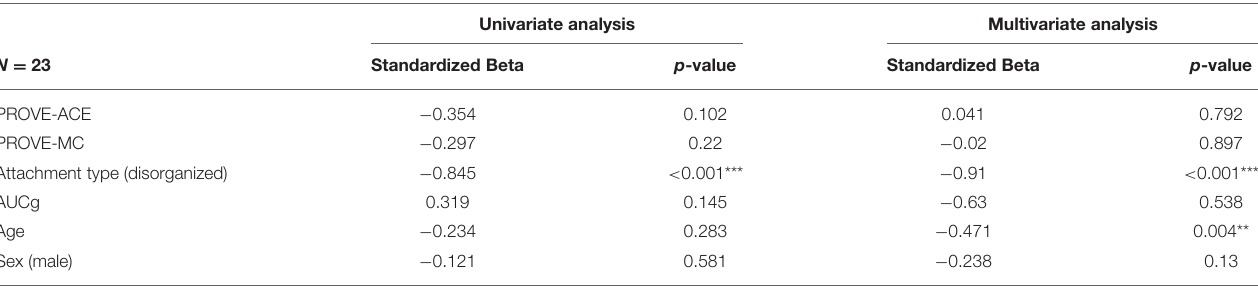
TABLE 3 | Linear regression analysis of resilience score in the red